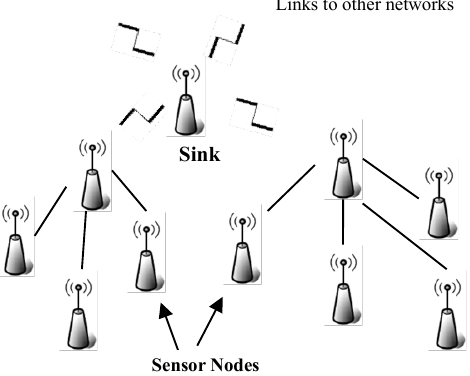
Figure 1. A typical WSN with sensor nodes and base station or